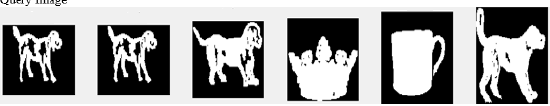
Figure 7. Image4 retievals using Histogram Of Oriented Gradients